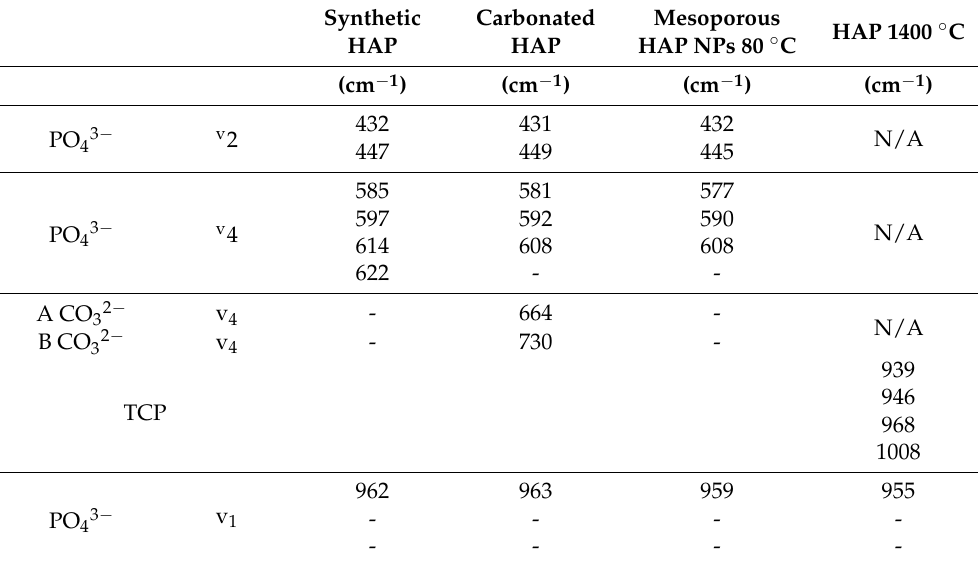
Table 2. Observed and assigned Raman bands from different HAP samples and natural